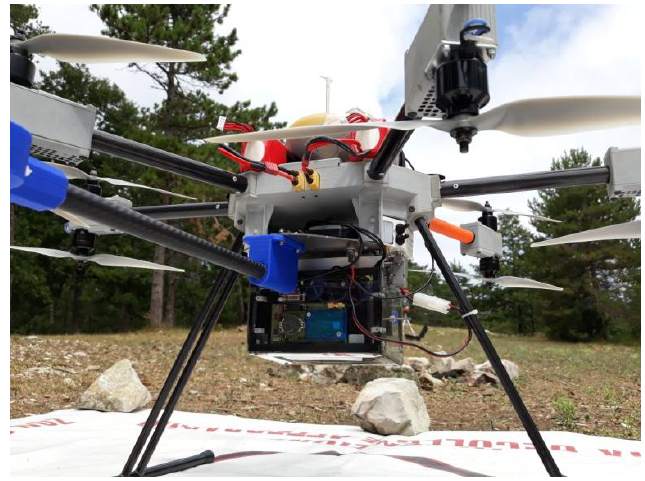
Figure 3. The LiDAR system mounted in the hexa-coaxial rotor UAV with the sensors isolated by the case containing the laser scanner, the GNSS/INS, the GNSS RTK receiver, and antennas.